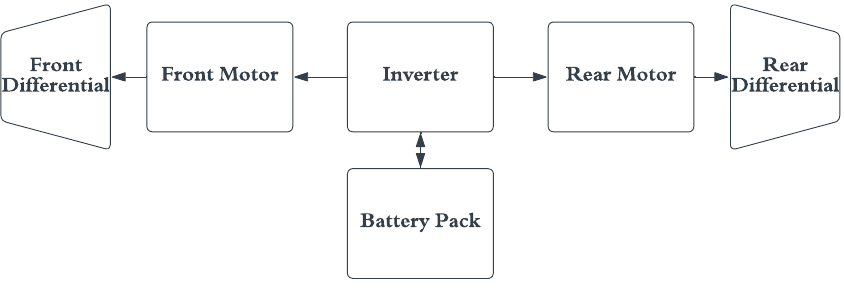
Figure 2. Drive system of a fully electric vehicle.